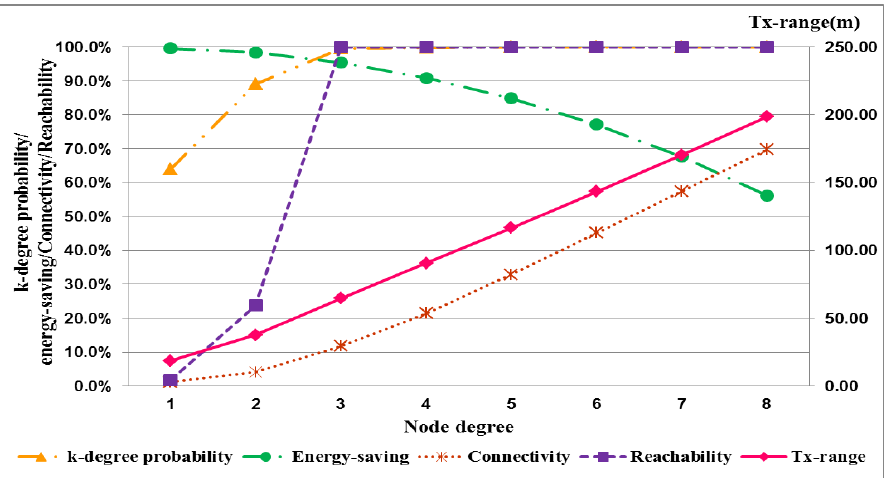
0.0005 nodes/m 2 .